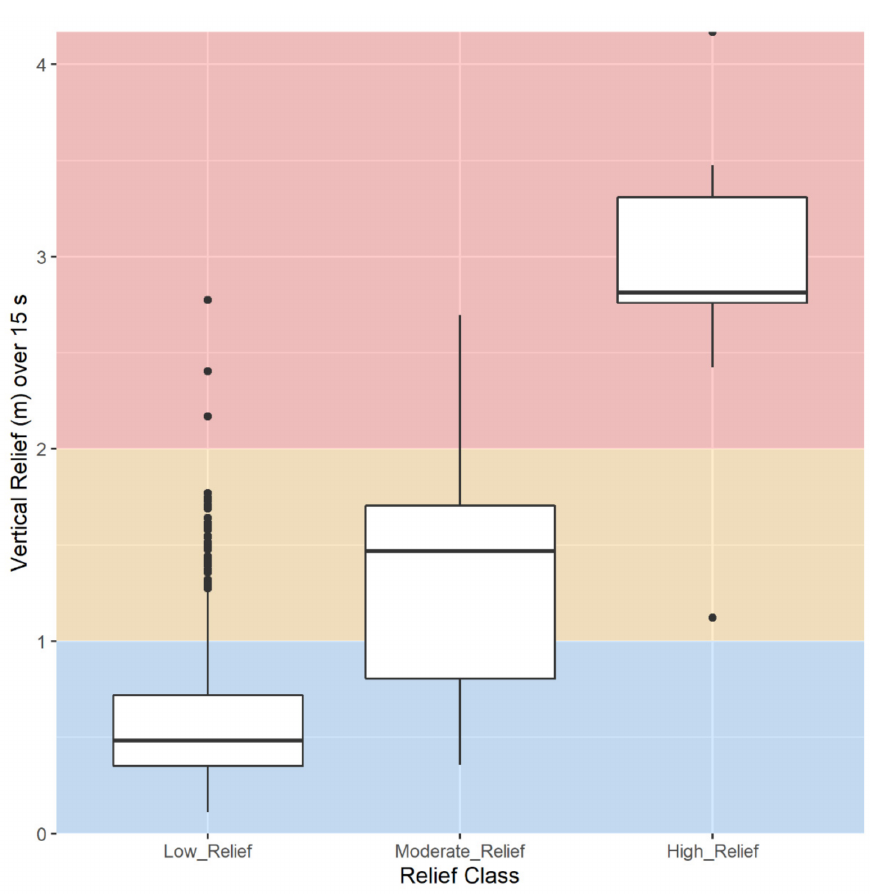
Figure A1. Box plot of vertical relief over 15 s time bins for each relief class. Re- lief was calculated from C-BASS’ onboard sensors, where total depth was calculated as CBASS_Depth + CBASS_Altitude*cos(CBASS_Pitch), and the relief was calculated as the max(Total_Depth)-min(Total_Depth) for each 15 s time bin. The blue, orange, and red areas represent the range of relief values that correspond to low, medium, and high relief, respectively, based on the cutoffs provided by Smith et al. [30]. Table A1. Habitat-specific densities for all observed taxa in number of individuals/m 2 as determined from the towed video